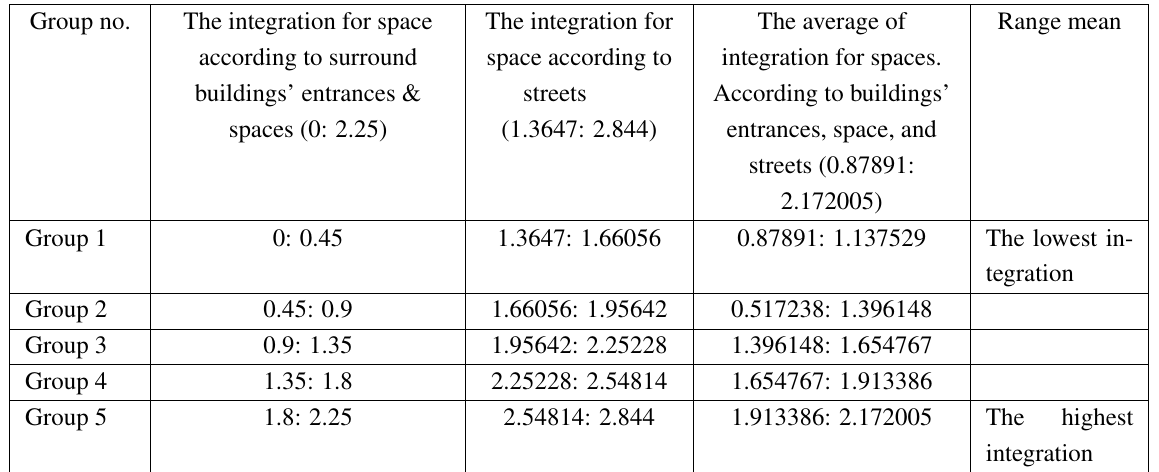
Table 2. the results of space’s integration and segregation